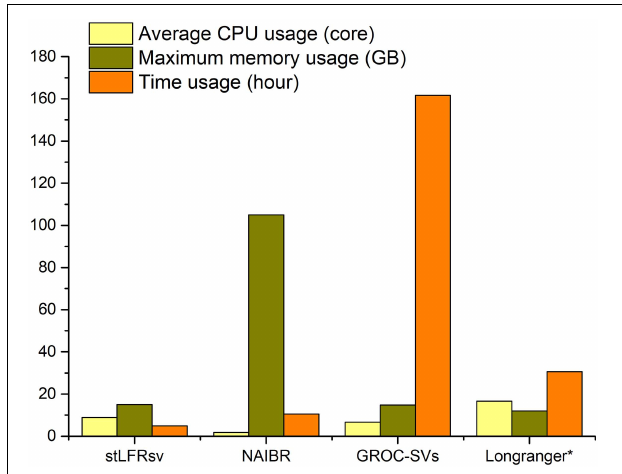
FIGURE 4 | The resource usage of four pipelines when processing 100 × stLFR reads of HG002 with the given parameters in Supplementary Table 1 . *The resource usage of Long Ranger is estimated by the log file because it is a fully integrated functional